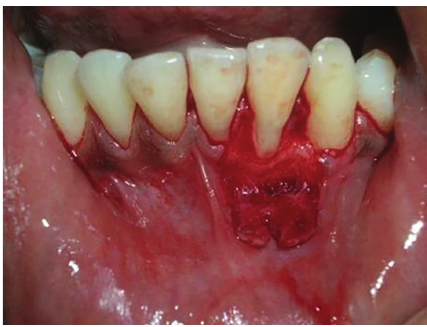
Figure 5: Partial thickness flap reflection in relation to tooth number 32.